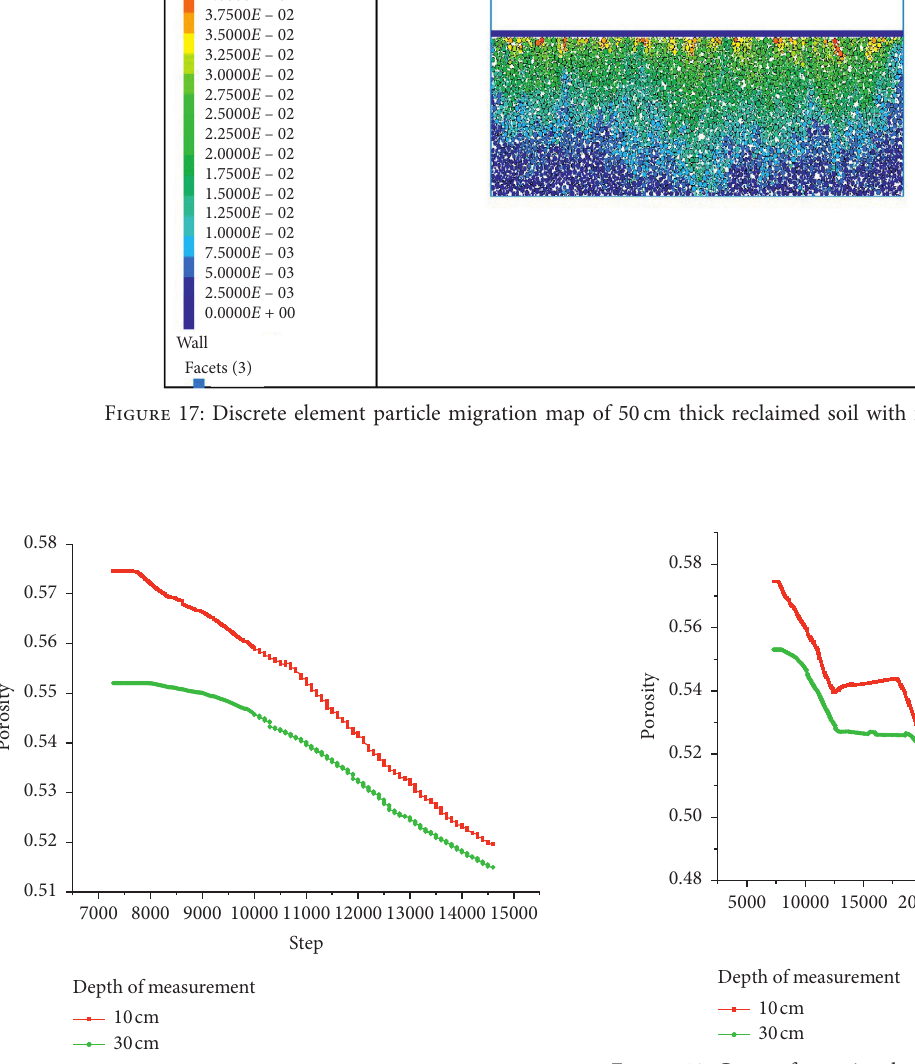
Figure 18: Curve of porosity change of 50cm thick reclaimed soil with one compaction.